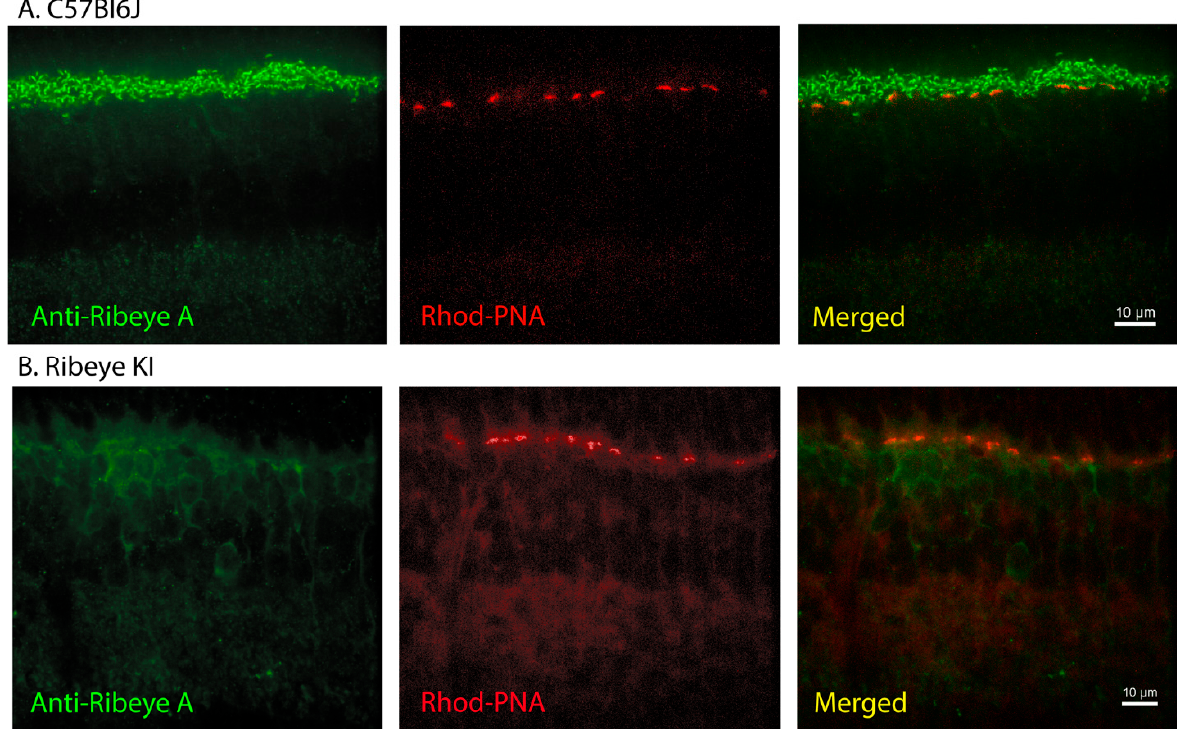
Figure 2. Labeling of synaptic ribbons with the A-domain antibody was eliminated in the Ribeye KI mice. ( A ) Wild-type C57Bl6J retina labeled with the primary antibody to the A-domain of RIBEYE (Synaptic Systems, 192-104) and visualized with an Alex488-conjugated second antibody strongly labeled ribbons in the OPL with weaker labeling of the IPL. Cone pedicles were labeled with rhodamine-conjugated PNA (red). ( B ) Labeling of ribbons in the OPL and IPL was absent from the Ribeye KI retinas. Weak labeling was seen in the outer region of the INL where bipolar cell bodies reside, suggesting that replacing the B-domain with GCamP3 impaired RIBEYE protein processing.